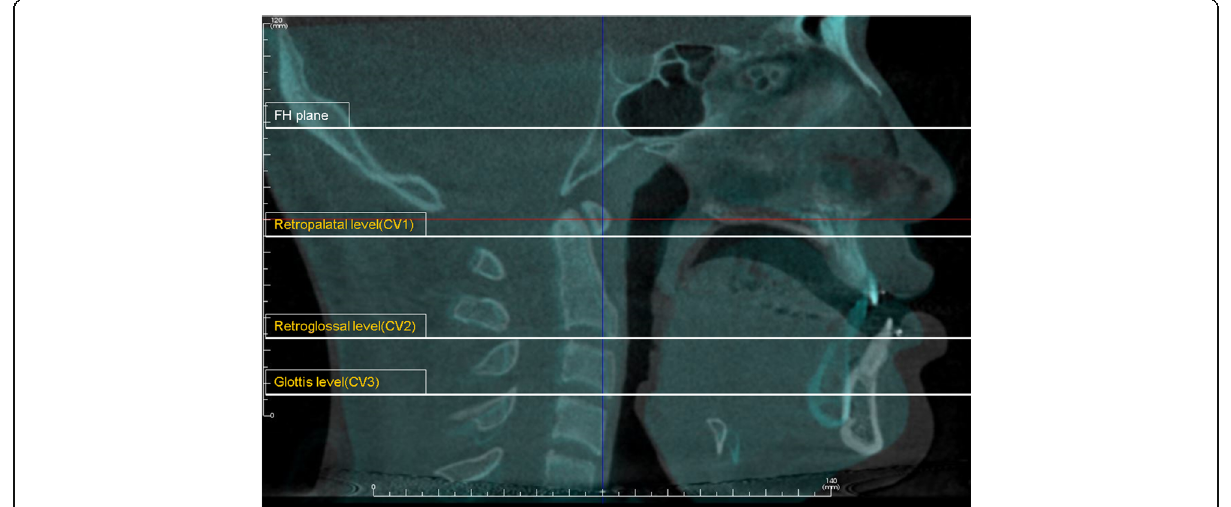
Fig. 1 Reference planes. CV1, CV2, and CV3 planes were parallel to the Frankfort horizontal